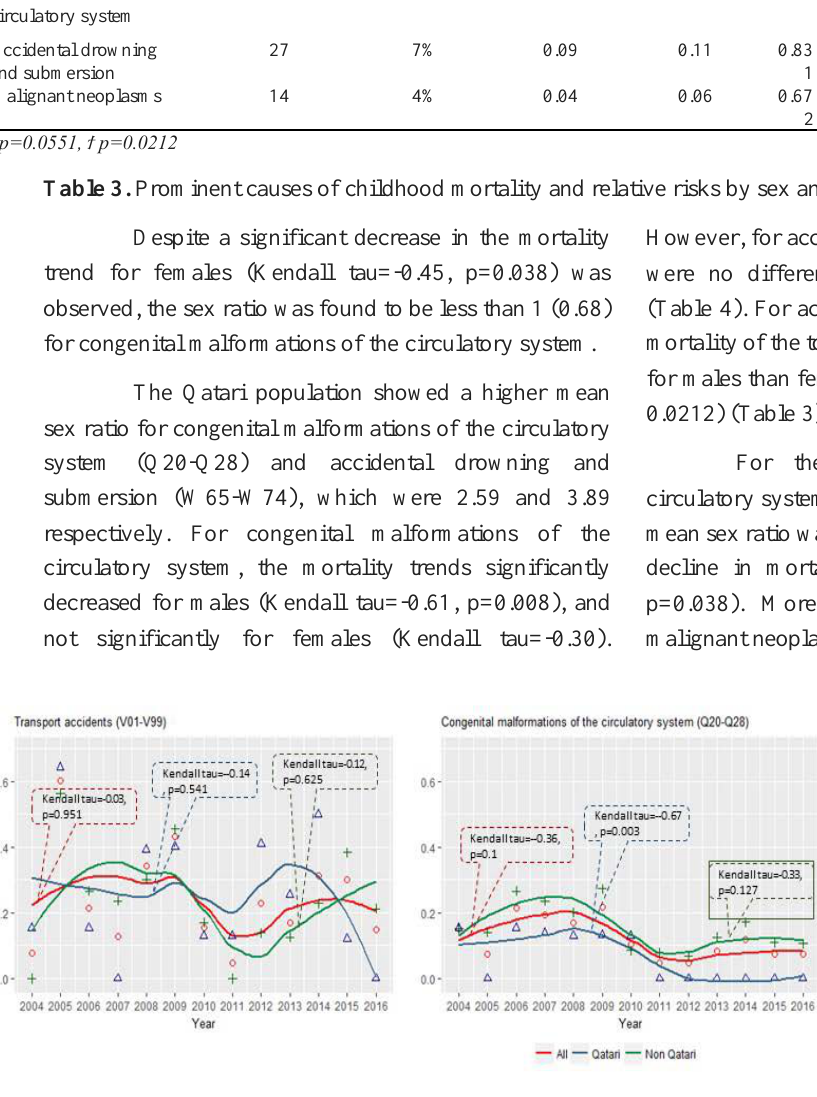
Figure 3. The distribution of the three major causes of child mortality from 2004 to